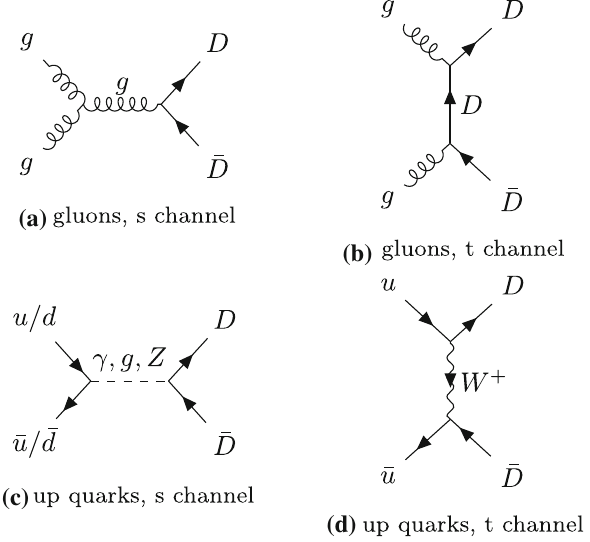
Fig. 2 pp → D ¯ D , q ¯ q → D ¯ D and gg → D ¯ D cross sections vs D quark mass for HL-LHC and FCC-hh energies, calculated using Com- pHep. The d − D mixing angle is taken as sin φ = 0 . 035